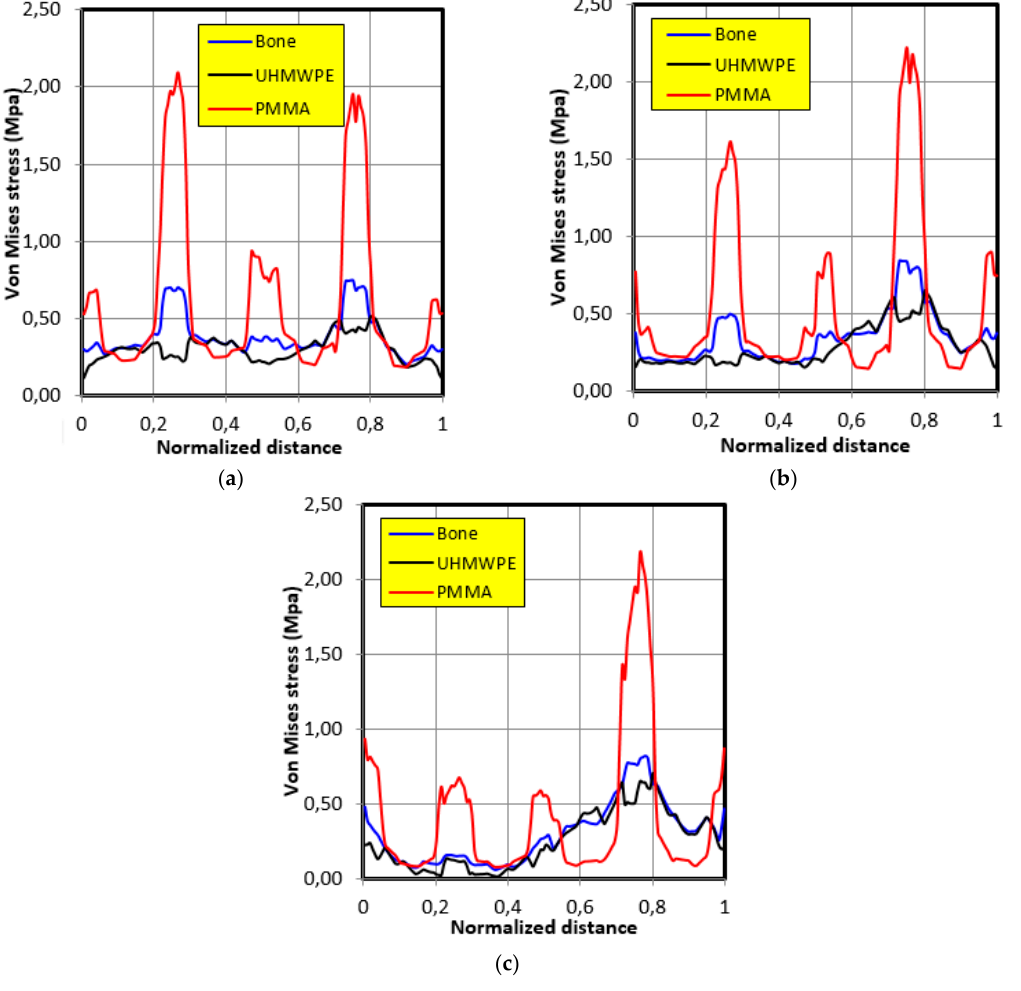
Figure 10. The Von Mises stresses distribution along the graft contour in the case of movement of individual 1. ( a ) 30° position; ( b ) 60° position; ( c ) 90° position.